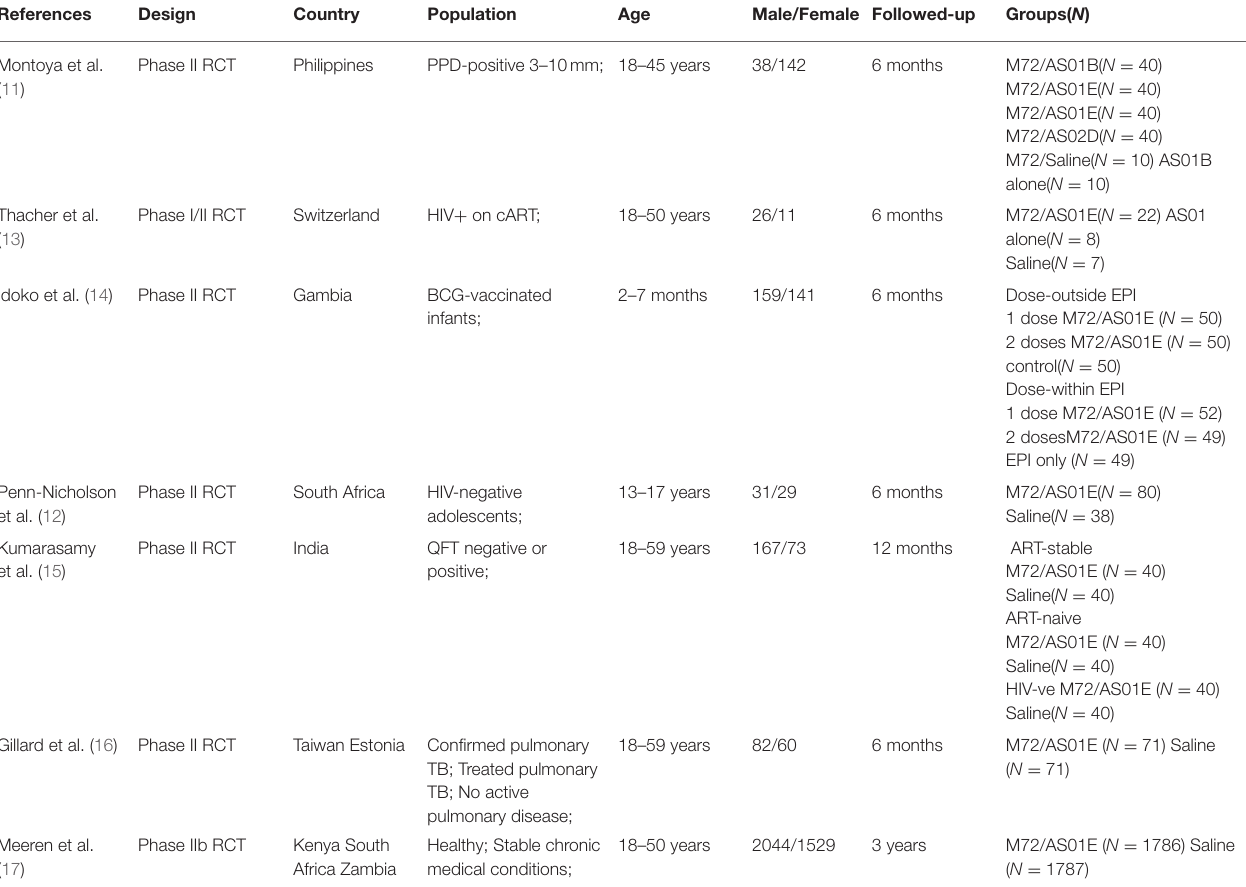
TABLE 1 | Characteristics of the studies included in the